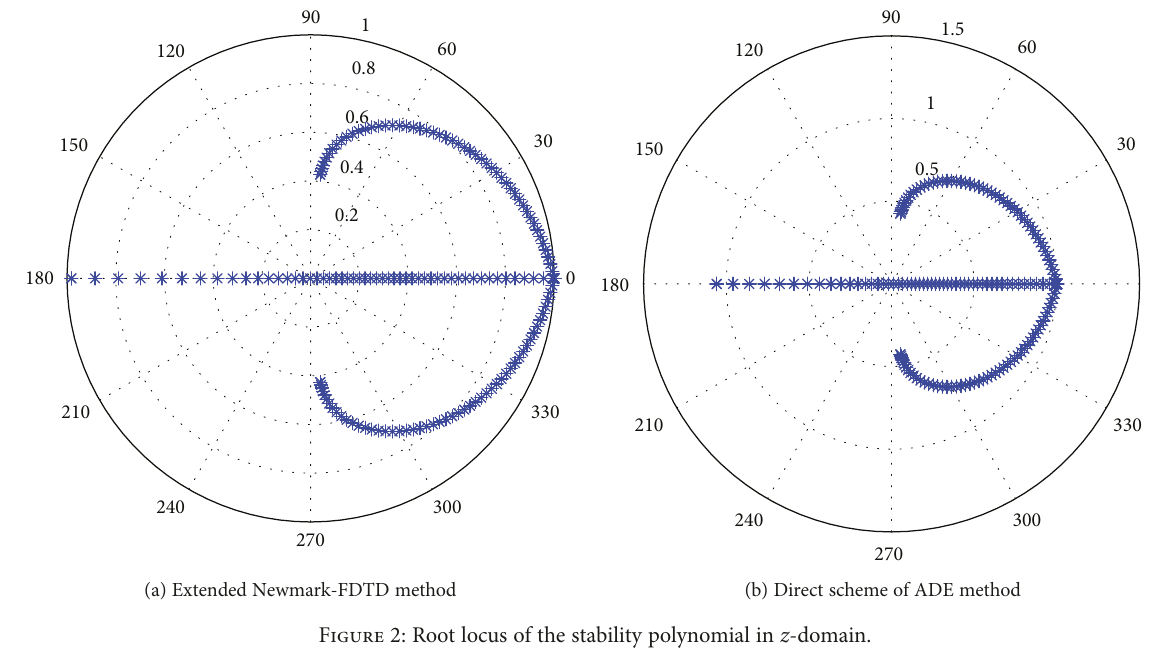
Figure 2: Root locus of the stability polynomial in z -domain.